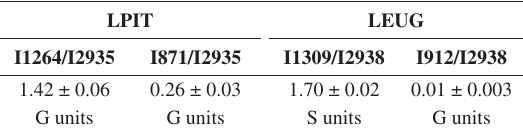
Figure 4. FTIR spectra of the lignins studied. Table 4. Differences in the guaiacyl and syringyl groups quantities presents in the both lignins studied.